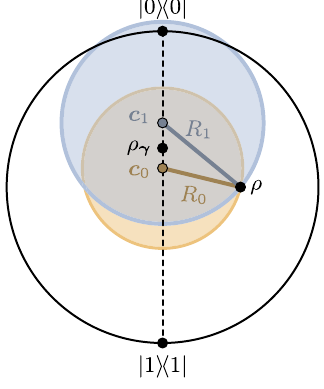
FIG. 7. Qubit accessibility region. Geometrically, states with a fixed value of R lie on a circle centered at c 0 and with radius R 0 þ (in orange). Similarly, states with a fixed value of R − lie on a circle centered at c 1 and with radius R 1 (in blue). States achievable from a given initial state ρ via quantum channels with a fixed point ρ γ lie inside the Bloch sphere in the intersection of two balls ð c 0 ; R 0 Þ and ð c 1 ; R 1 Þ . Here, the parameters for initial and fixed states are chosen to be x ¼ 1 = 2 , z ¼ 0 , and ζ ¼ 1 = 4